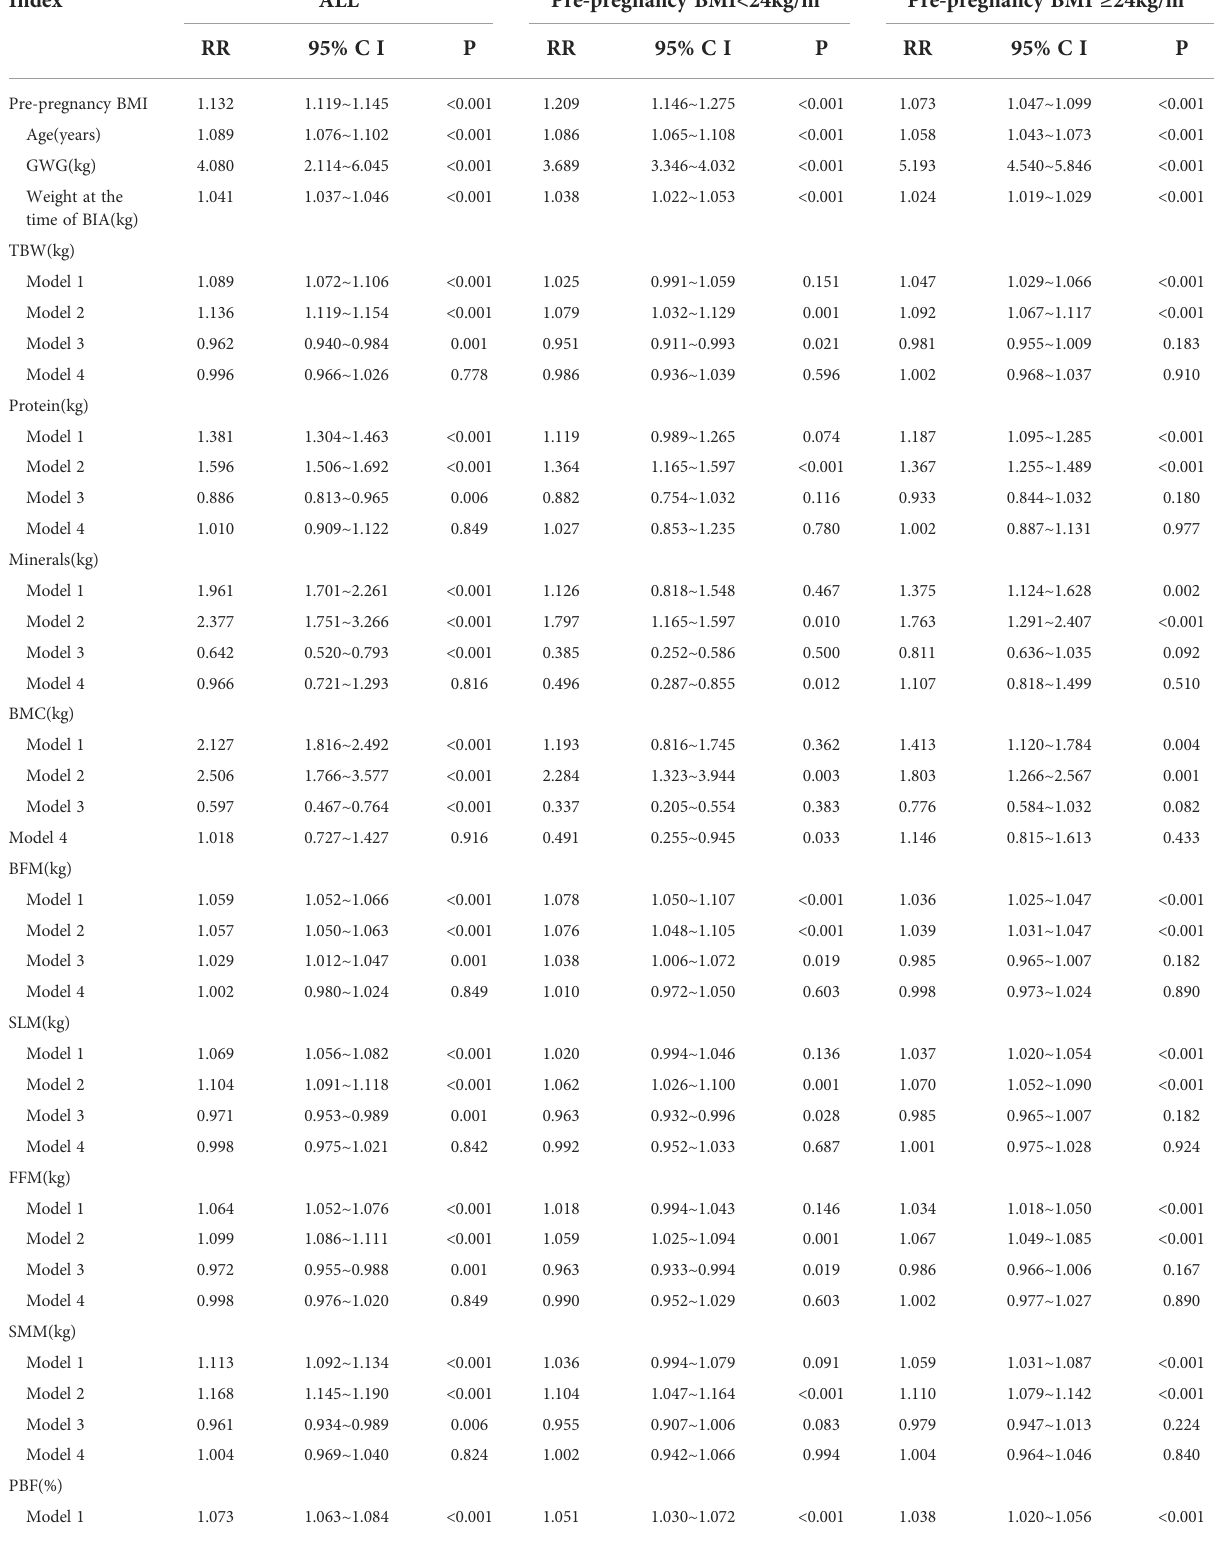
TABLE 4 Multivariate regression analysis of different pre-pregnancy BMI